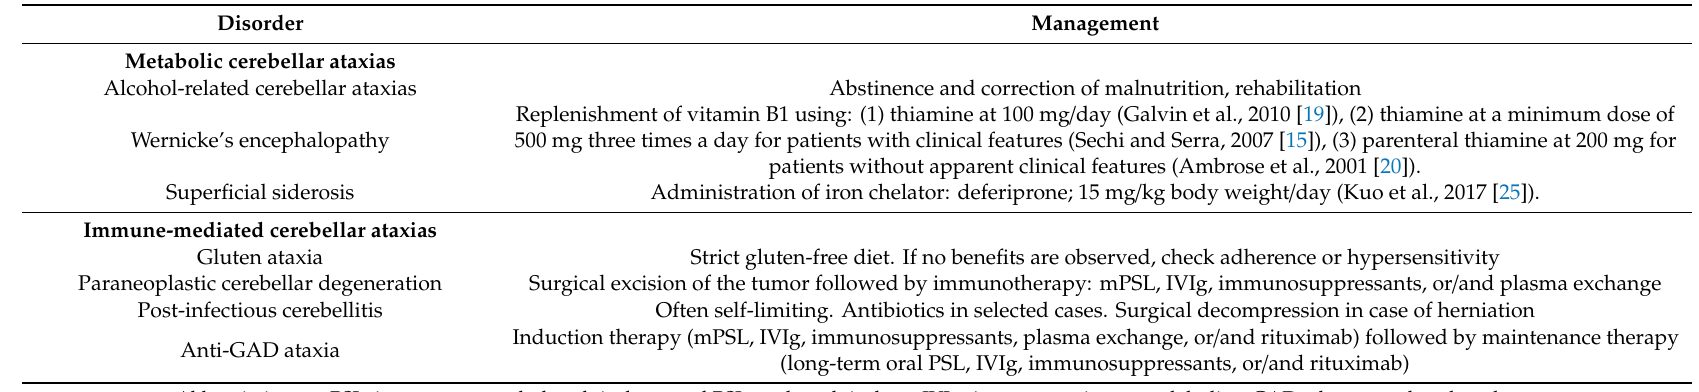
Table 1. Currently used therapies for metabolic and cerebellar